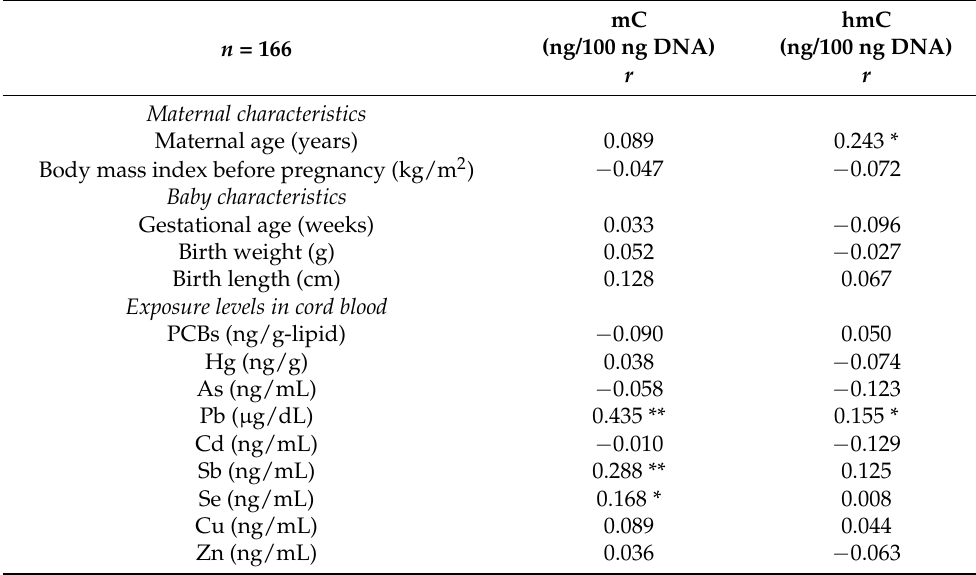
Table 2. Pearson product-moment correlation coefficients ( r ) between relating indicators and mC/hmC contents (ng/100 ng